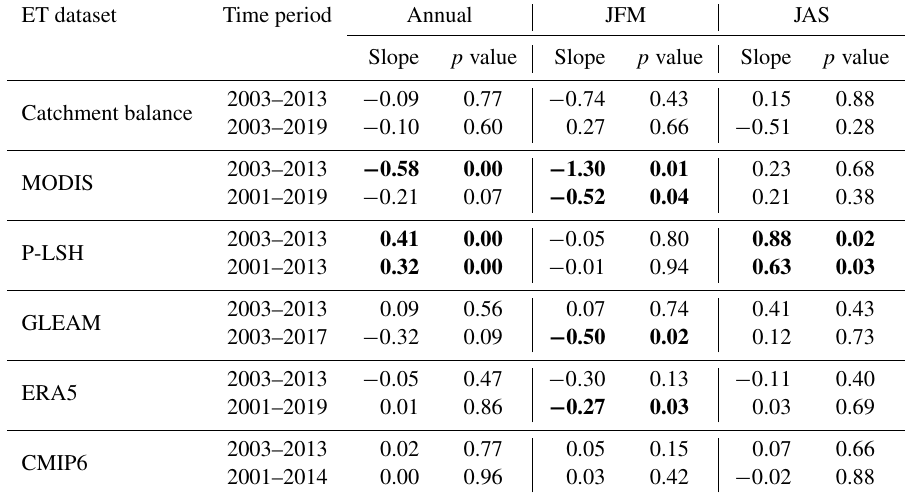
Table 3. Interannual trends in Amazon evapotranspiration (ET). Linear trends in annual, January–March (JFM), and July–September (JAS) ET were calculated over the time period common to all datasets (2003–2013) and for all years with available data over the past 2 decades (units of millimetres per month per year). Statistically significant ( p < 0 . 05) trends are shown in